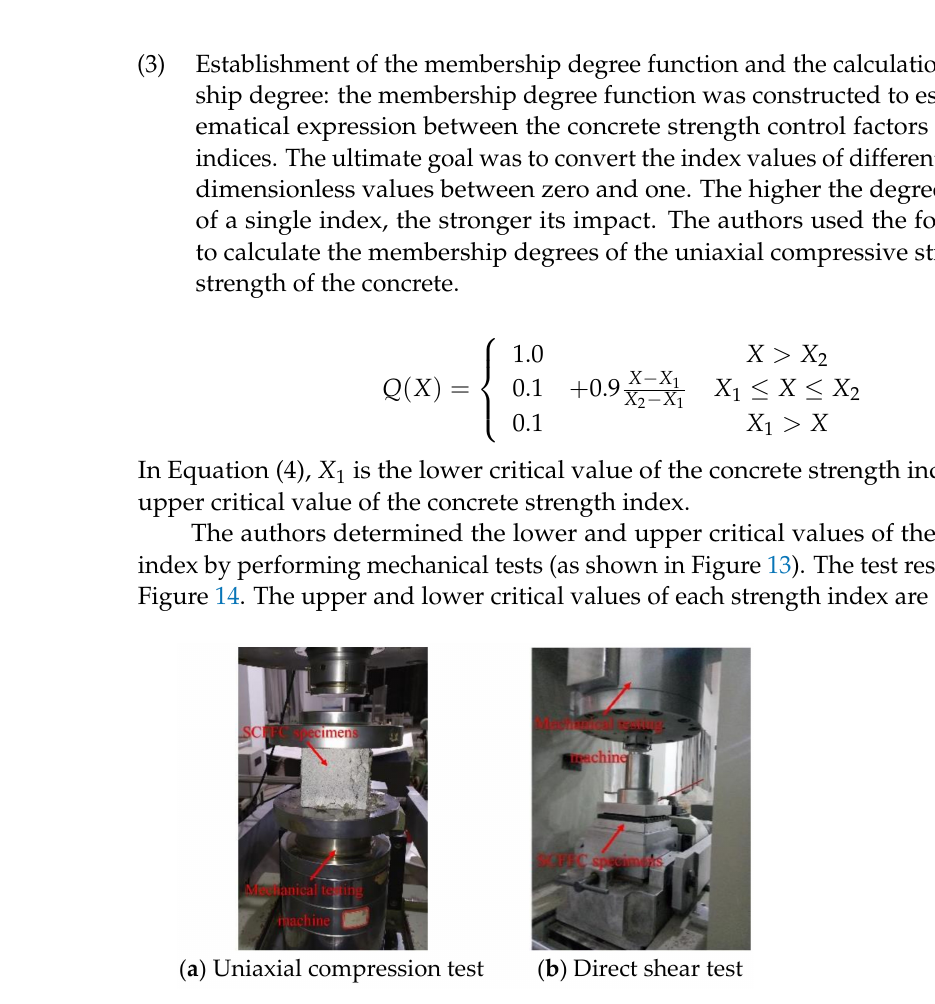
Figure 13. SCFFC mechanical test.